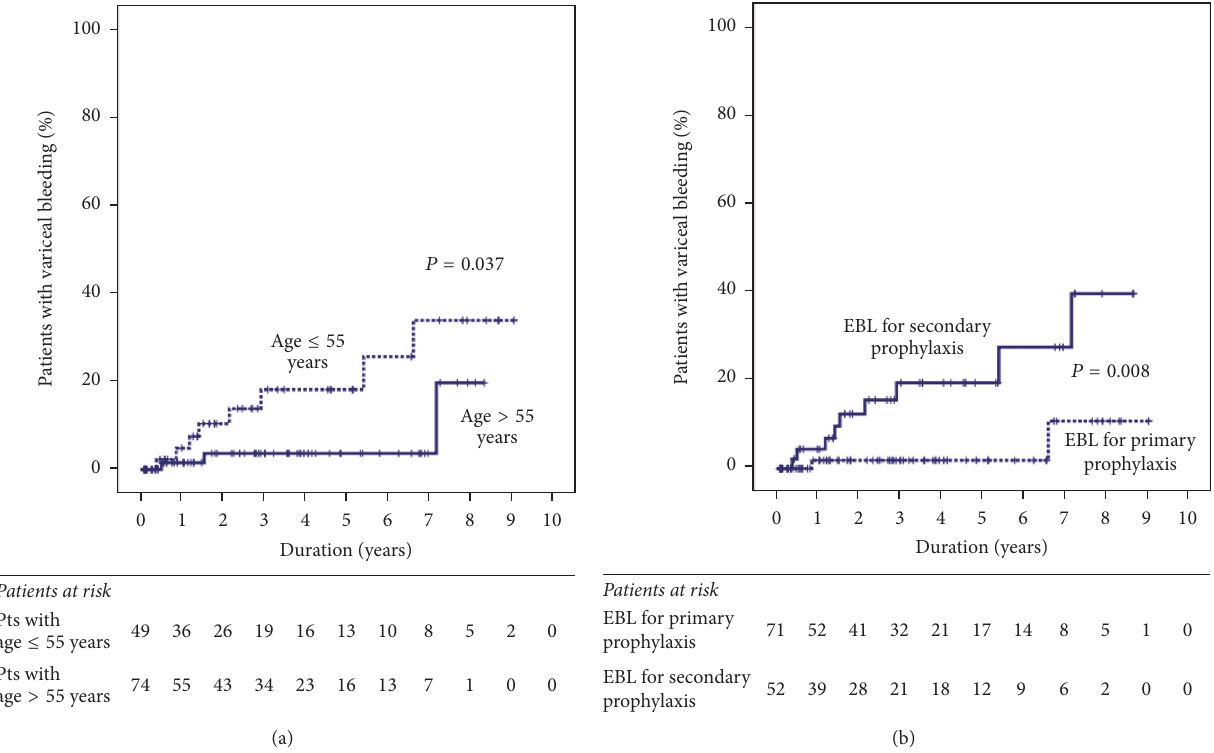
Figure 4: Cumulative incidence of variceal bleeding after eradication of esophageal varices by endoscopic band ligation—arranged according to (a) age and (b) the purpose of endoscopic band ligation. EBL: endoscopic band